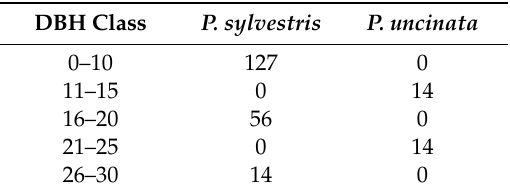
Table 3. Species distribution.